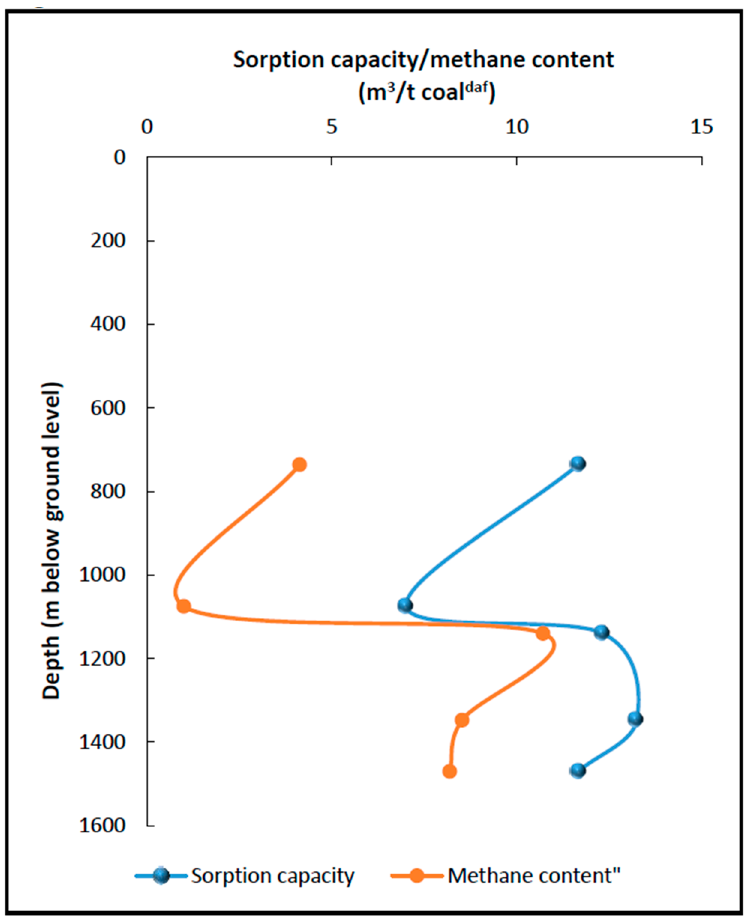
Figure 13. Sorption capacity and measured methane content vs. depth in Ć wiklice area, after